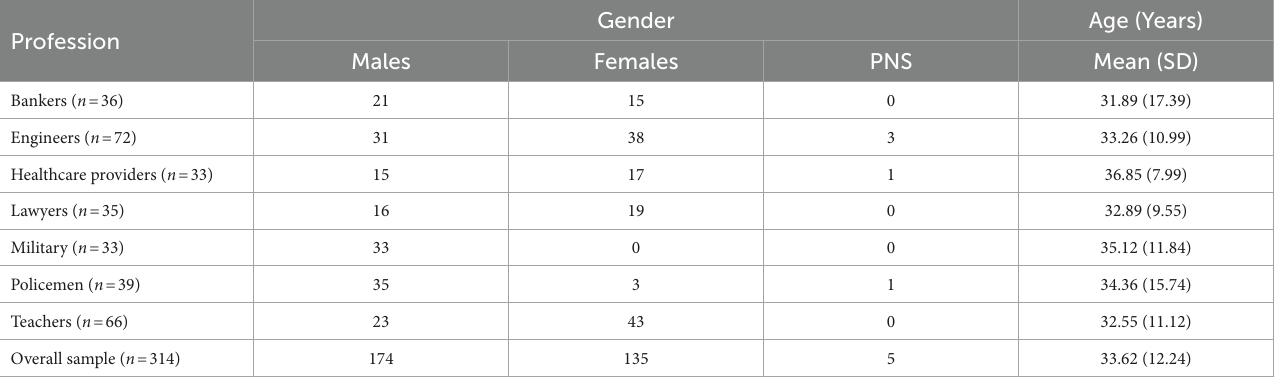
TABLE 1 Gender and age information for each profession represented in our